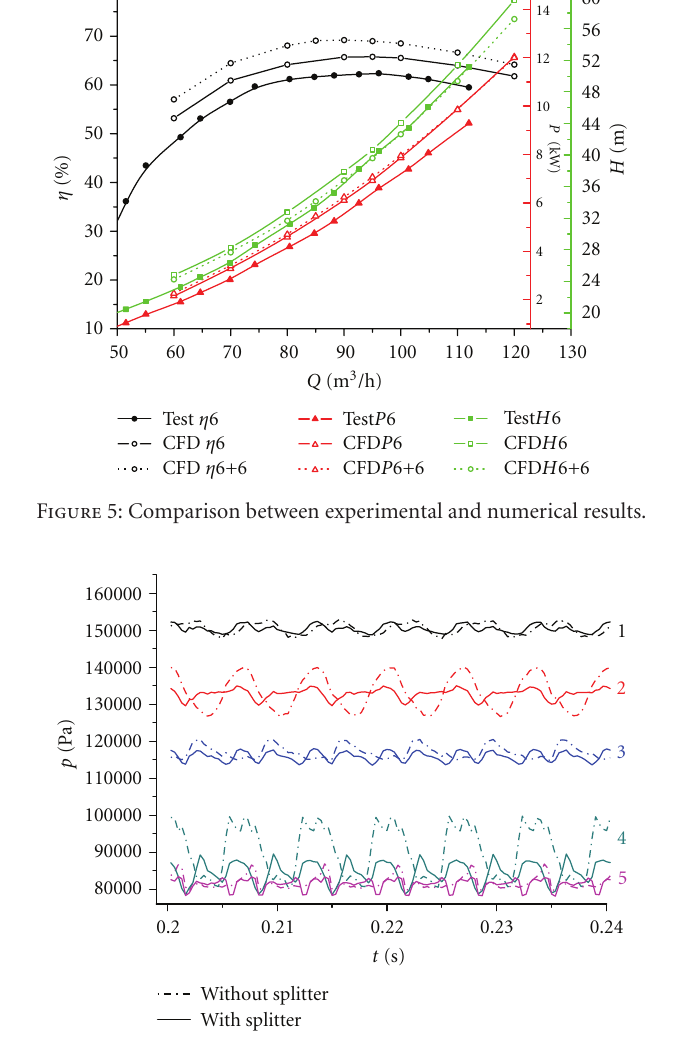
Figure 6: Time domain of pressure pulsation at volute monitoring